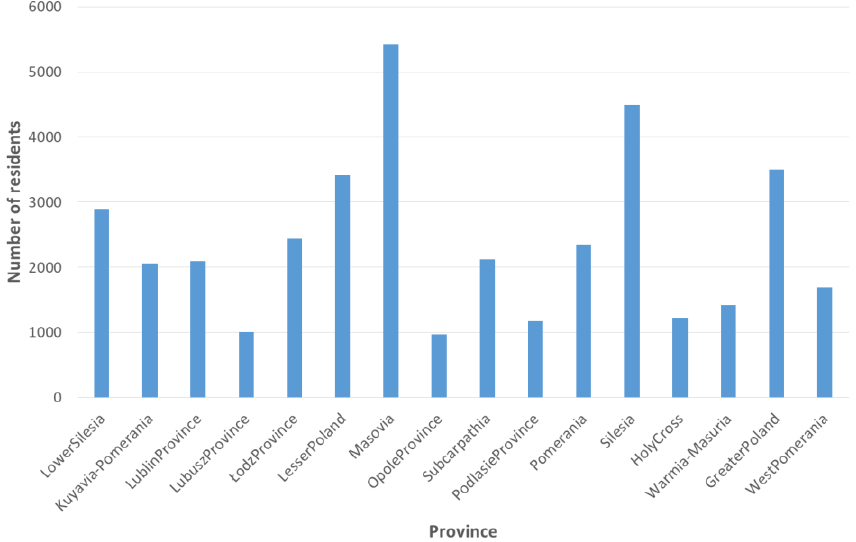
Figure 1. Population of Poland from 2001 to 2020 (thousand people) [62]. Table 1. Area, population by province in Poland in 2020 [62].